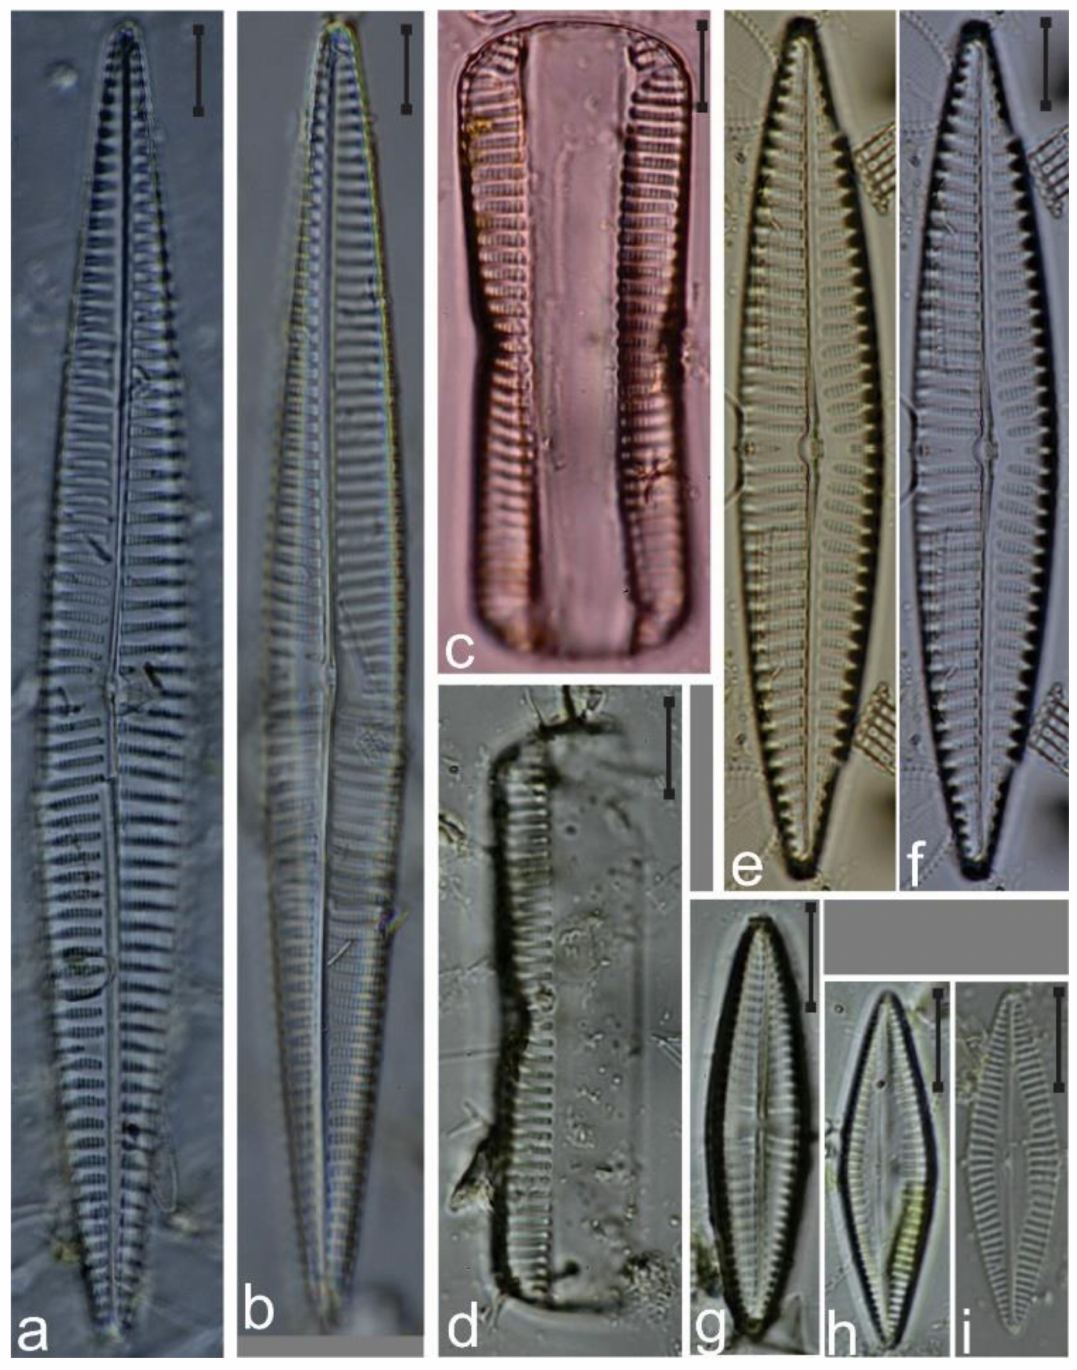
Figure 32. ( a , b ) Navicula longa var. irregularis ; ( c , g ) N. cancellata , images c and g whole frustule and valve view, respectively; ( d ) N. pennata valve in girdle view; ( e , f ) N. longa var. longa ; ( h , i ) N. palpebralis var. angulosa . Scale bar = 10 µ